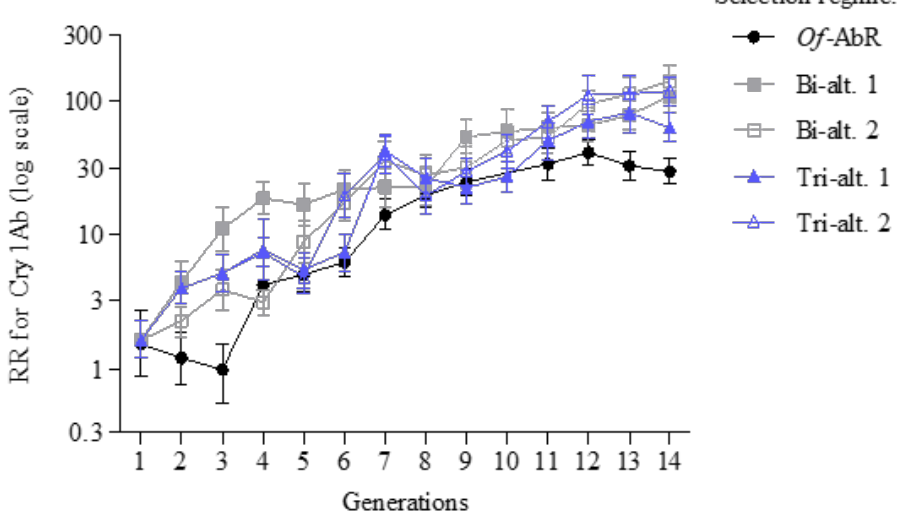
Figure 1. Evolution of resistance to Cry1Ab in O. furnacalis with different Bt toxin treatments. Of -AbR, selected with Cry1Ab alone. Bi-alt.1, selected with Cry1Ab-Cry1F in alternation. Bi-alt.2, selected with Cry1Ab-Cry1Ie in alternation. Tri-alt.1, selected with Cry1Ab-Cry1F-Cry1Ie in alternation. Tri-alt.2, selected with Cry1Ab-Cry1F-Cry1Ie-Cry1F in alternation.